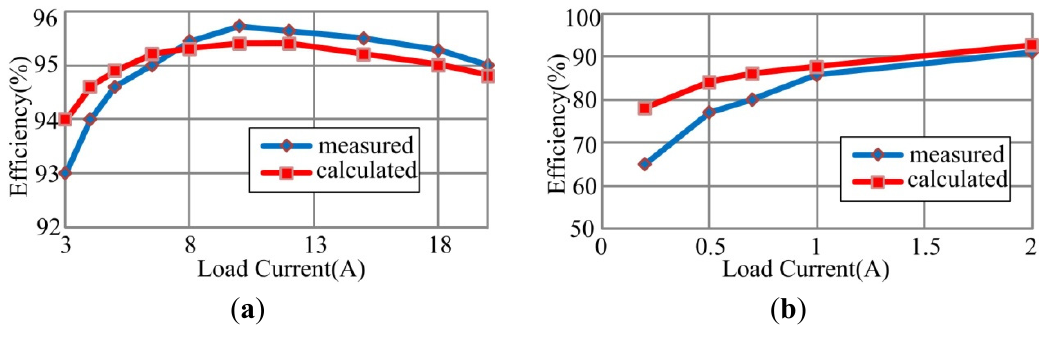
Figure 29. Calculated efficiency versus measured efficiency at different loads. ( a ) Efficiency curves under mid and heavy loads; ( b ) Efficiency curves under light